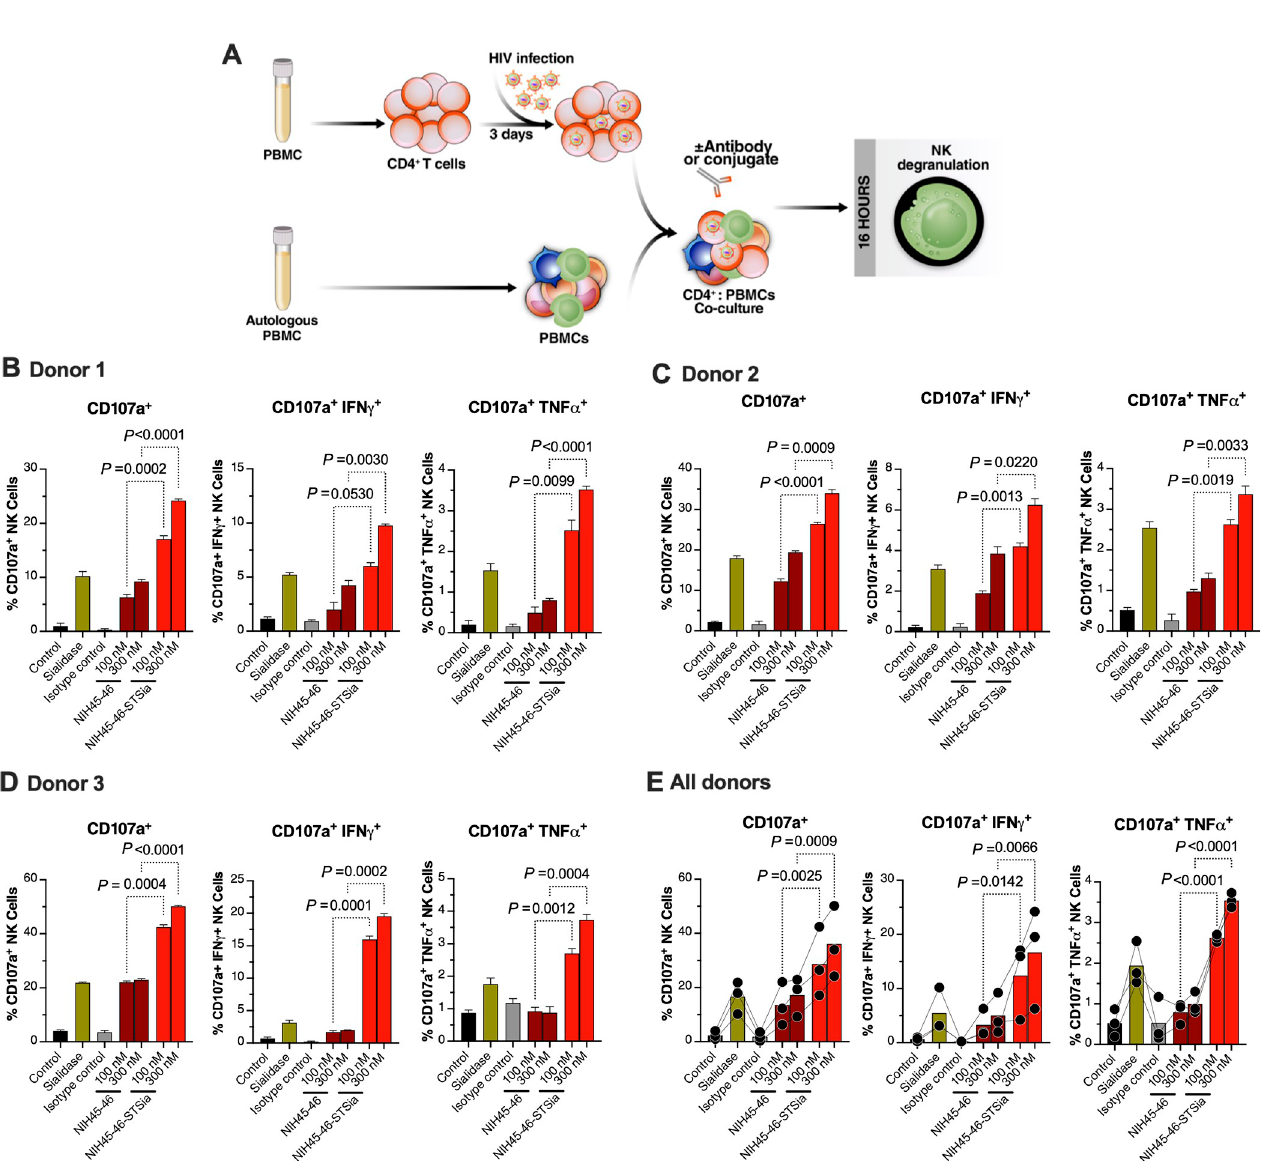
Fig 8. NIH45-46-STSia induces NK degranulation towards autologous primary HIV-infected CD4 + T cells. (A) A schematic representation of the workflow to evaluate effector NK degranulation against autologous HIV-infected CD4 + T cells in the presence of bNAb or bNAb-STSia conjugate. CD4 + T cells were isolated from fresh PBMC and exposed to HIV-1 IIIB for 72 h. On the third day, virus-infected CD4 + T cells were treated or not with Sialidase, NIH45-46, NIH45-46-STSia, or isotype-matched control antibody. PBMC from the same donor were co-cultured with autologous HIV-infected CD4 + T cells in the presence of CD107a antibody for 16 h. Following overnight incubation, the mixtures were stained with a cocktail of antibodies for CD3, CD56, IFN- γ , and TNF- α . Percent NK cell positive for CD107a, IFN- γ , and TNF- α expression was derived after gating on CD3 - CD56 dim NK cells. Control = data from the NK cells + HIV-infected CD4 + T cells condition. All other conditions contain NK cells + HIV-infected CD4 + T cells, in addition to the indicated reagent. (B) Data from donor 1. (C) Data from donor 2. (D) Data from donor 3. (E) Average data from all donors. Assay from each donor was performed in 4 replicate wells (E:T 10:1; n = 3 donors). Statistical analyses for panels B-D were performed using unpaired ANOVA with post-hoc Dunnett T3 method (to correct for multiple comparisons) comparing the indicated groups. Statistical analysis for panel E was performed using paired ANOVA with post-hoc Holm-Sidak method (comparing the indicated